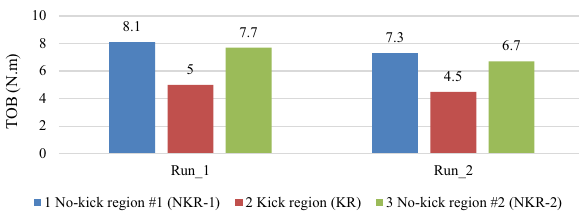
Fig. 23 Kick effects on TOB for experimental Run_1 and Run_2